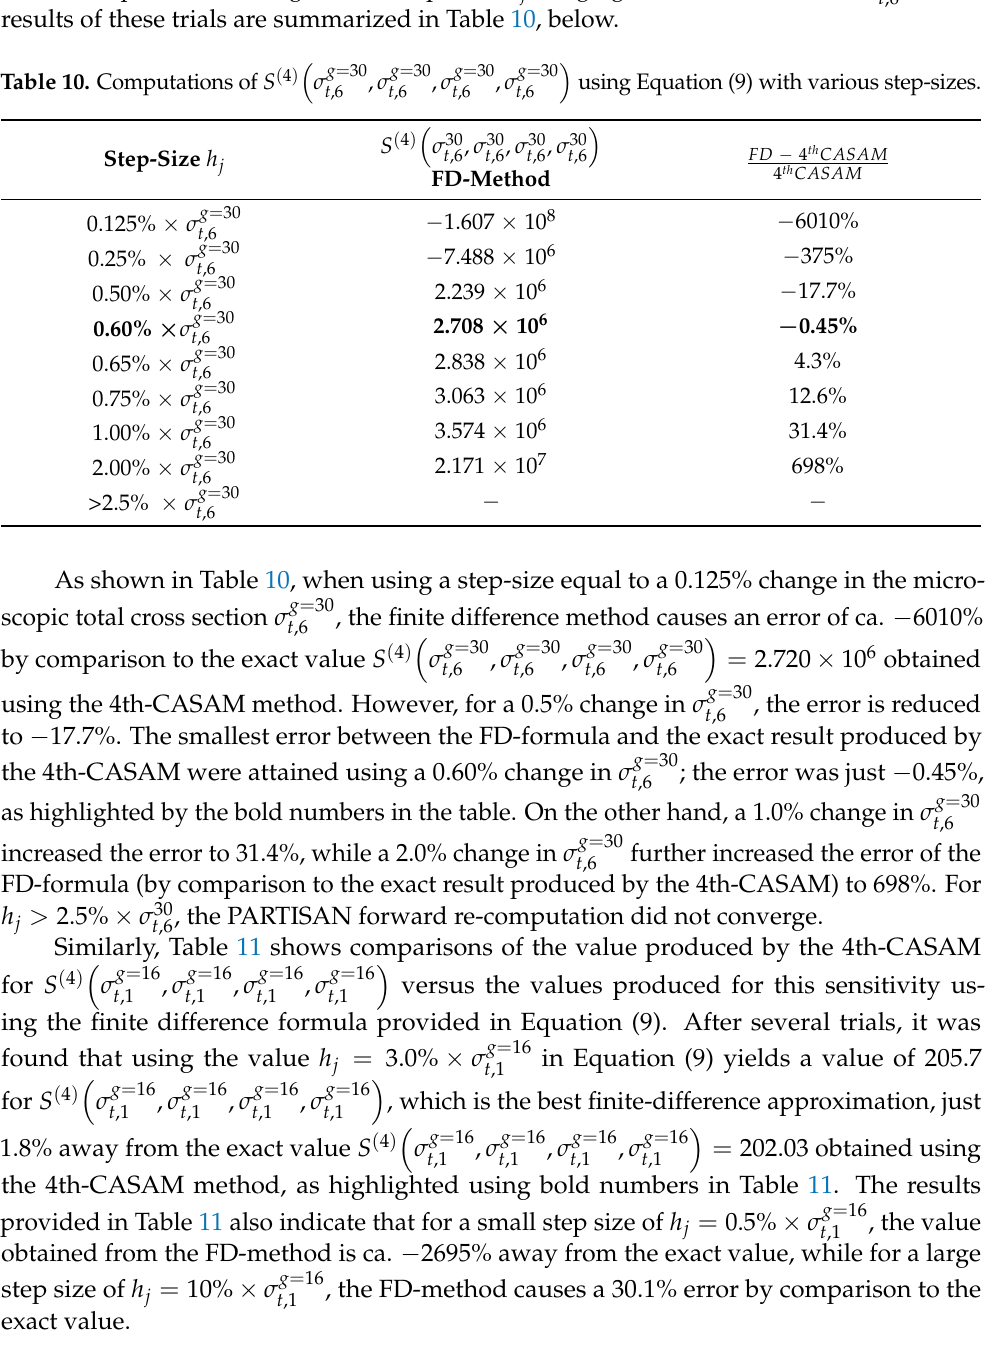
Table 10. Computations of S ( 4 )